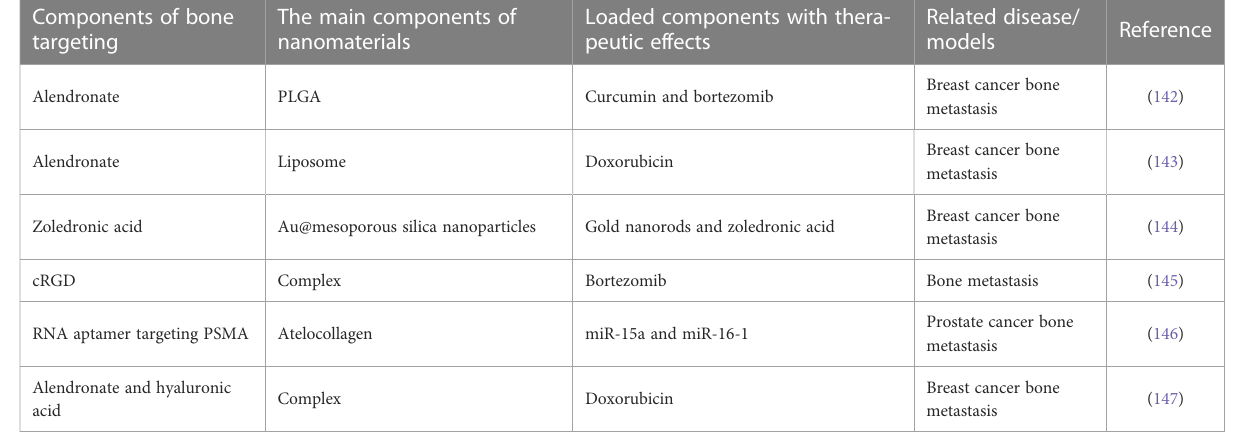
TABLE 4 Representative studies related to nanomaterials with bone targeting drugs for the treatment of bone metastases. Components of bone targeting